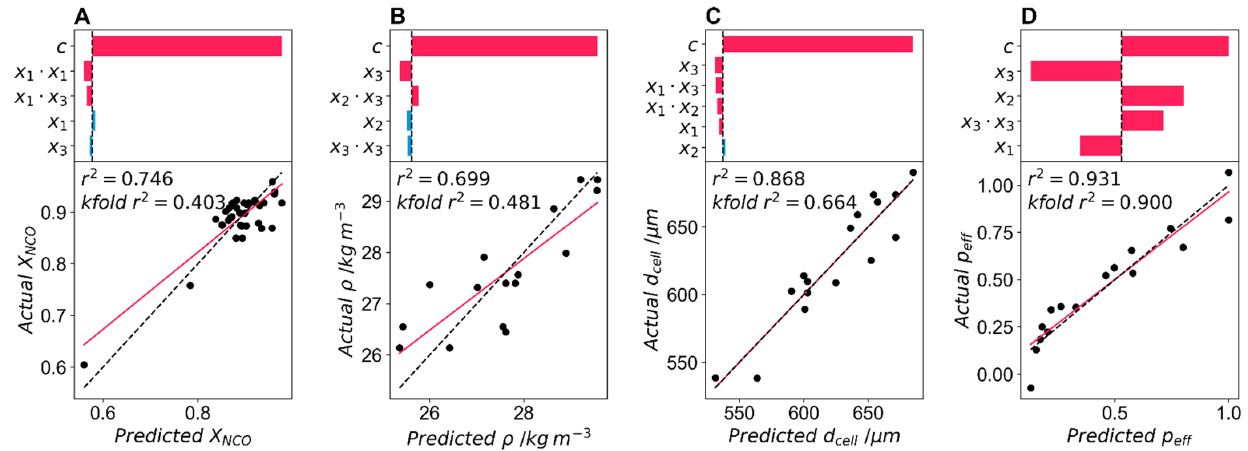
Figure 9. Model fitting figures for the kinetic and cell morphology responses. The t-ratio for each of the model coefficients is shown in the top part of each subplot, with the pink bars indicating an absolute value t-ratio of greater than 2 (and a p < 0.05) and blue bars indicating an absolute value t-ratio below 2 (and a p > 0.05). The vertical dotted line indicates the zero axis. The bottom chart shows the predicted and actual foam properties, with the solid line indicating the fit and the dashed line showing the y = x line. Figures are displayed for ( A ) NCO conversion, ( B ) density ( C ) cell size and ( D ) effective open cell fraction.